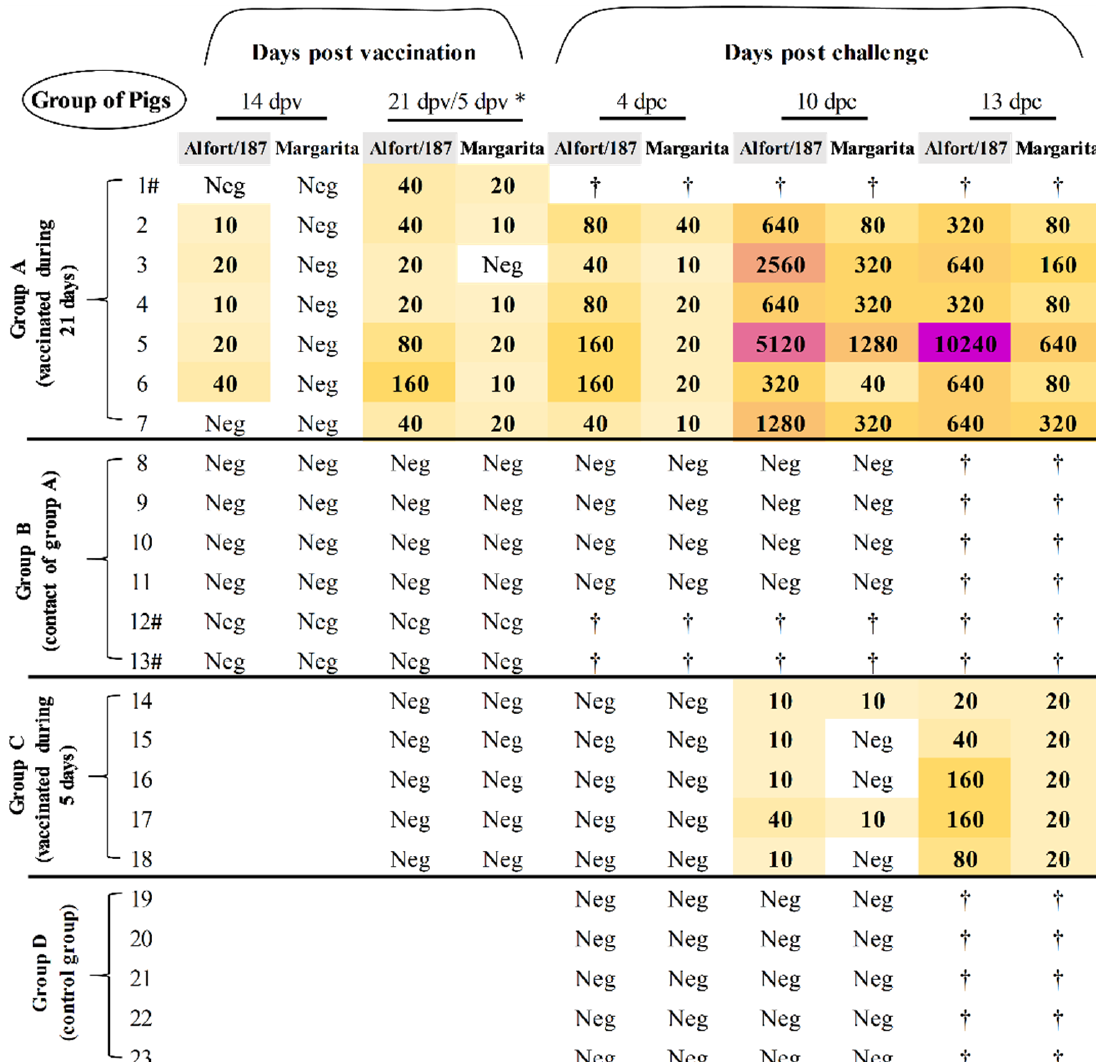
CSFV RT-qPCR (Figure 6a,c). Between 7 and 10 dpc (time of euthanasia), the CSFV RNA load was significantly higher than the vaccinated pigs ( p < 0.05), being mostly moderate by the CSFV RT-qPCR and high in the Margarita-specific test. All the tissue samples from these groups were positive by both assays, exhibiting mostly high RNA load that was statistically different ( p < 0.05) to the vaccinated pigs (Figure 6 and Figure S1).